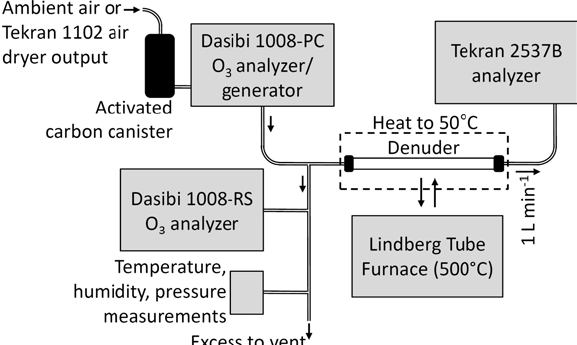
Figure 2. Schematic of analytical system for quartz denuders. Tubing shown is 0.64 cm outer 2 Fig. 2. Schematic of analytical system for quartz denuders. Tub- ing shown is 0.64cm outer diameter PFA. Denuders were coupled diameter PFA. Denuders were coupled to tubing via PTFE-lined thermoplastic caps. Mass 3 to tubing via PTFE-lined thermoplastic caps. Mass flow is shown flow is shown (STP of 0°C, 1013 mb). 4 (STP of 0 ◦ C,